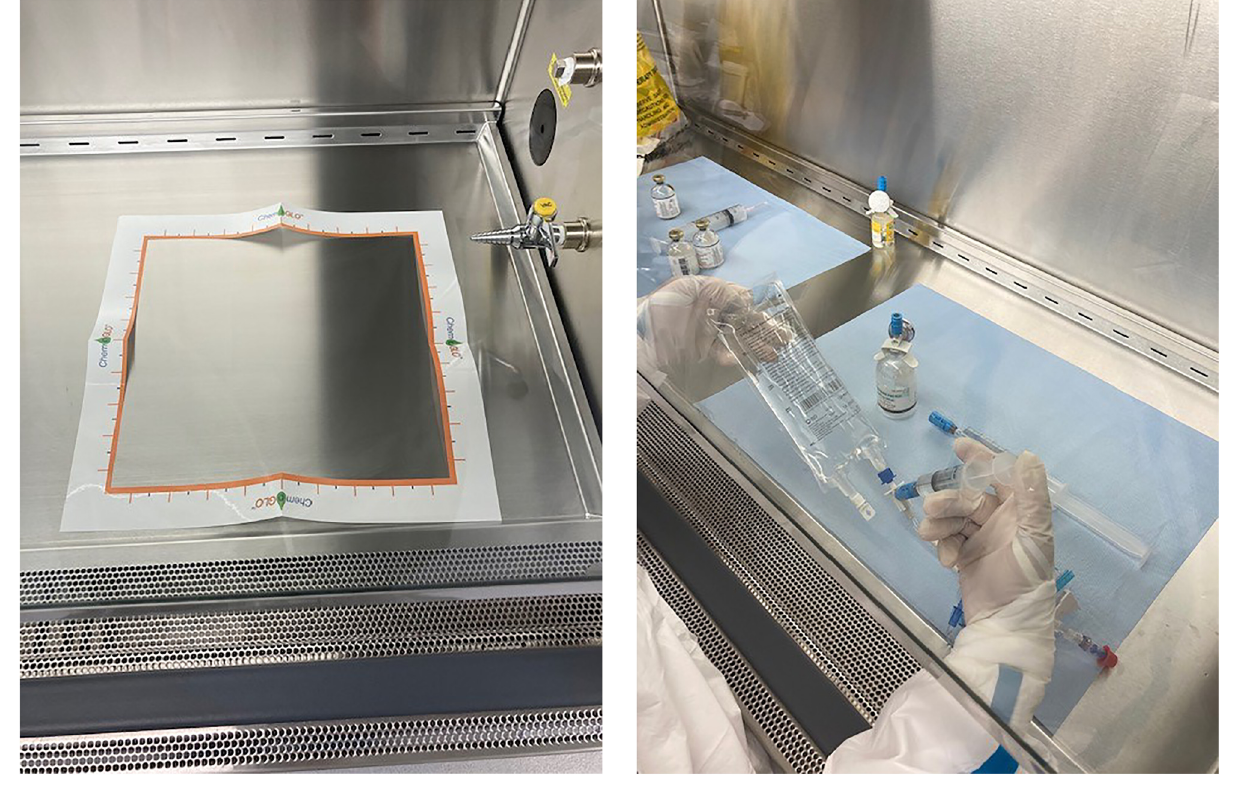
Figure 1: HD sampling area inside the BSC. Figure 2: Compounding activities inside the BSC, prior to HD sampling